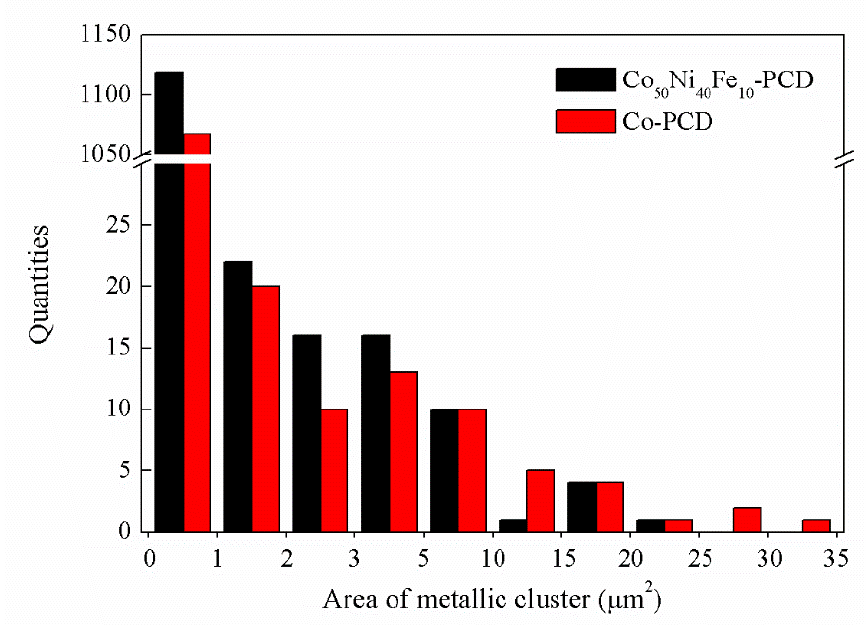
Figure 4. Statistics of area of metallic clusters in Figure 3a,c.